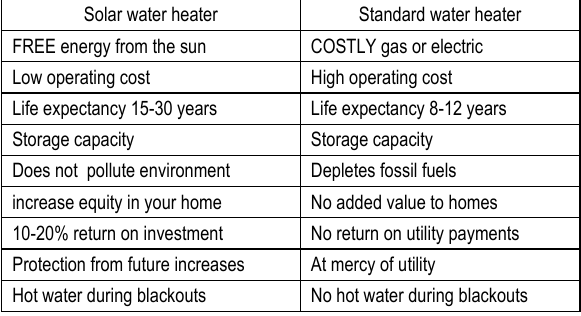
Table 1. Comparison of solar water heaters to